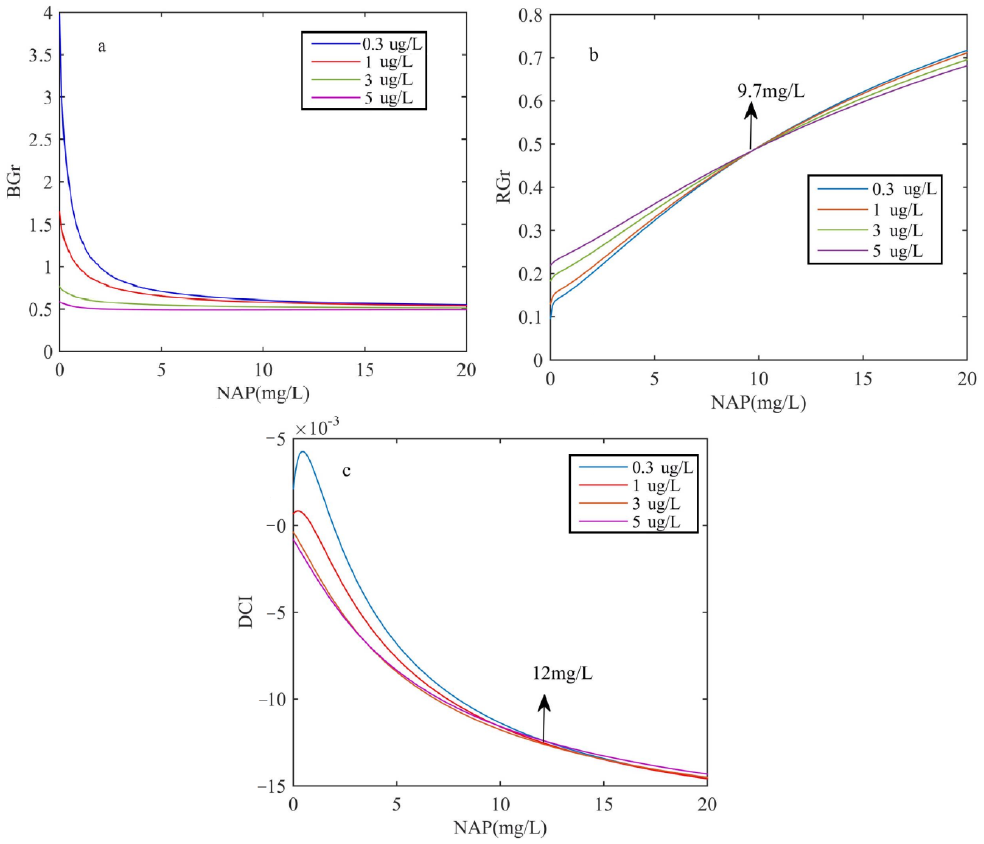
Figure 24. Plots of the two-band reflectance ratio or the difference at different concentrations of Chl-a versus the concentration of NAP. ( a ) BGr versus the concentrations of NAP; ( b ) RGr versus the concentrations of NAP; ( c ) DCI versus the concentrations of NAP.